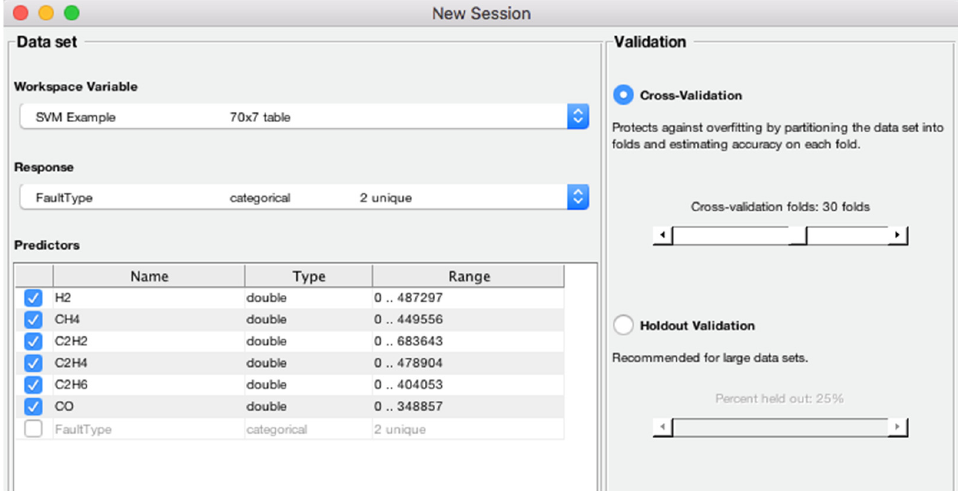
Figure 5. The dataset variables were selected by the SVM 1 classifier.